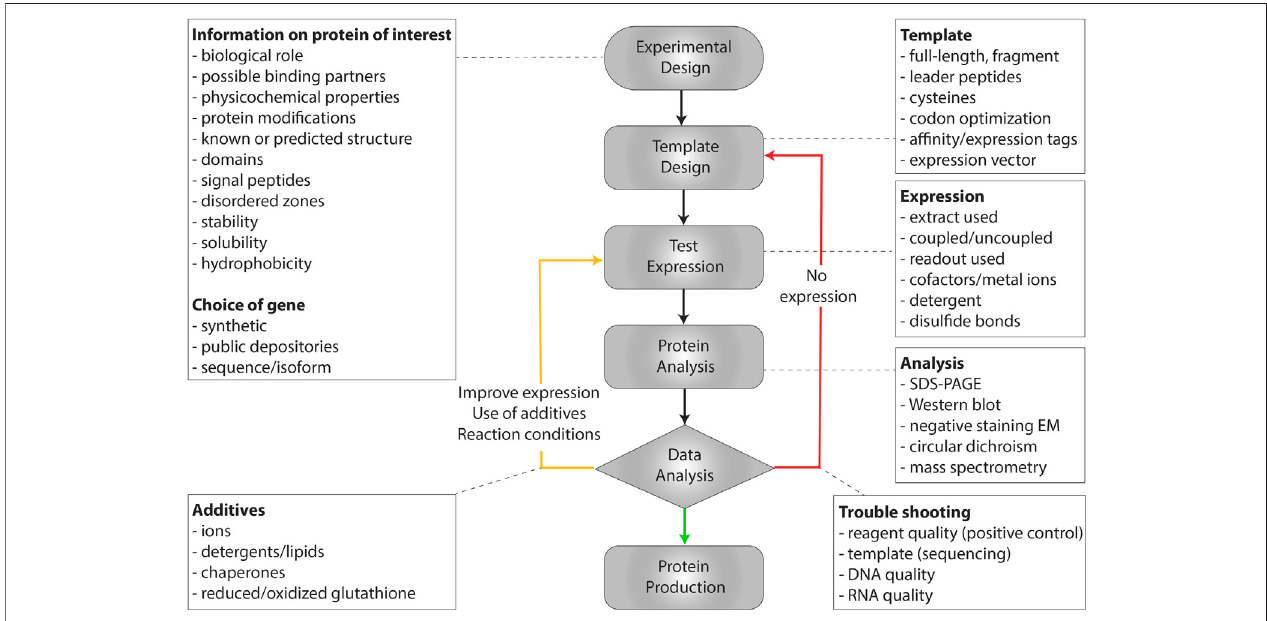
FIGURE 2 | Work fl ow to establish protein synthesis in a WGS, with key points given at each